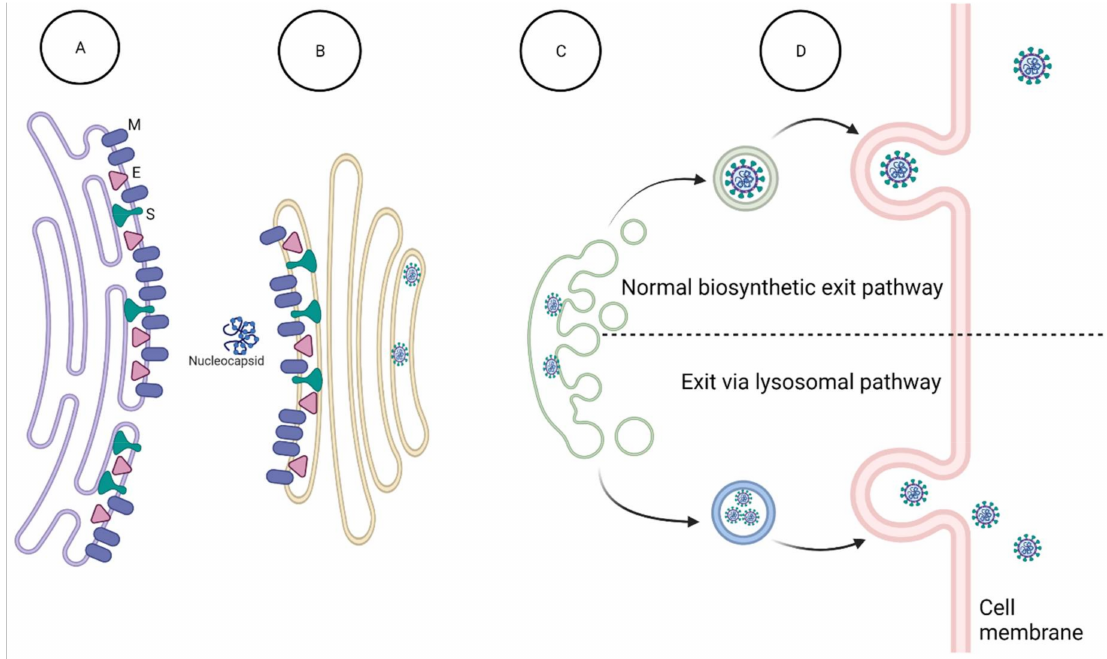
Figure 11. Coronavirus assembly and exit. Translation results in coronavirus protein expression followed by viral genome replication. ( A ) Upon translation, N binds viral genomic RNA to form the nucleocapsid. Translation of M, E, and S proteins occurs in the endoplasmic reticulum (ER). ( B ) Viral assembly is initiated by viral protein–protein interactions between M and N of the nucleocapsid, along with M interaction with both E and S in the ER Golgi intermediate complex (ERGIC). ( C ). Virions traffic to the Golgi apparatus for glycosylation and post-translational modifications of viral surface proteins. ( D ). Virions are either released in vesicles as part of the normal cellular secretory exit pathway, or virions are released via the cellular lysosomal pathway. Created with